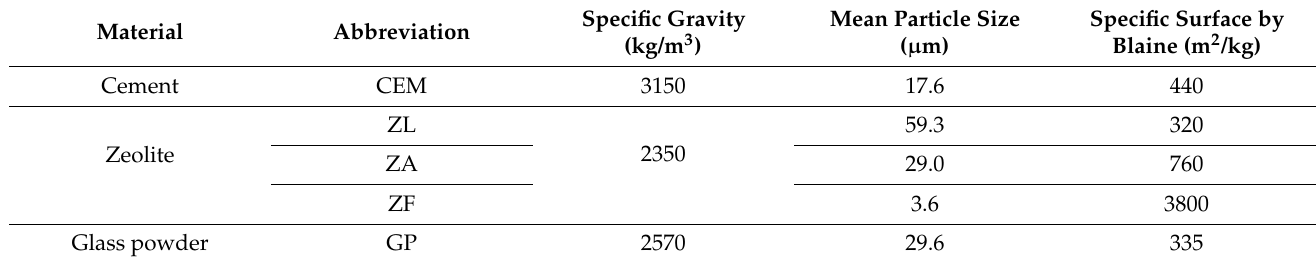
Table 2. Properties of cement, natural zeolite and glass.